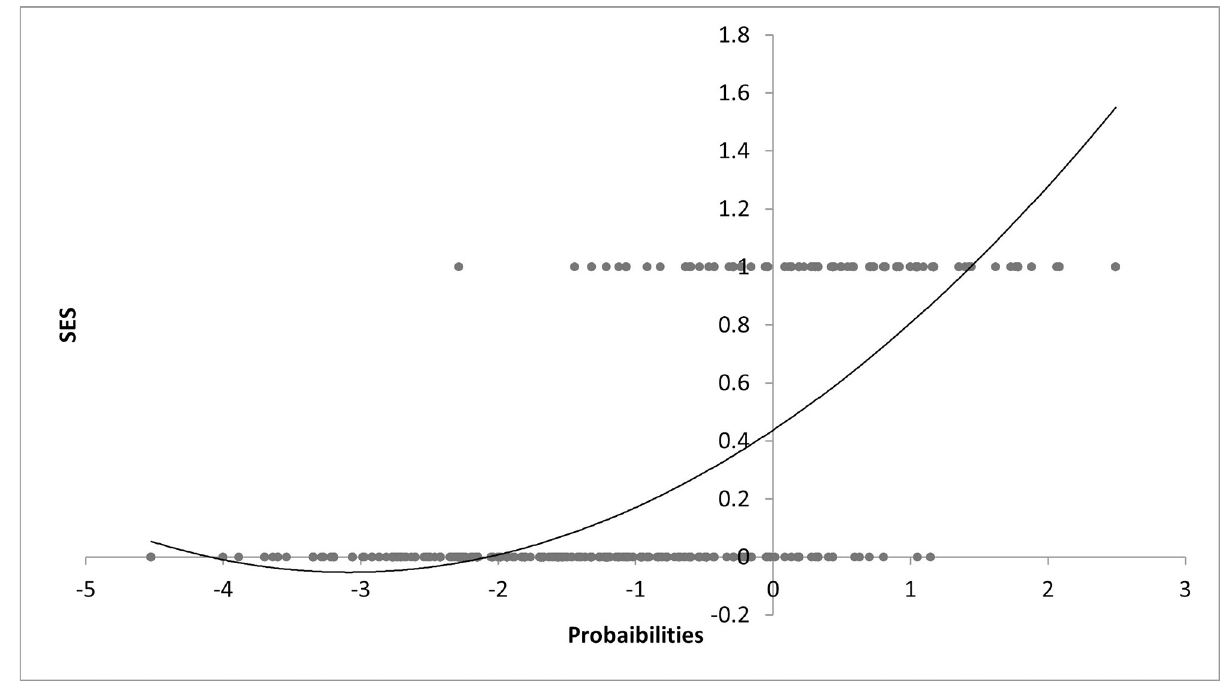
Fig 3. Predicted probabilities and